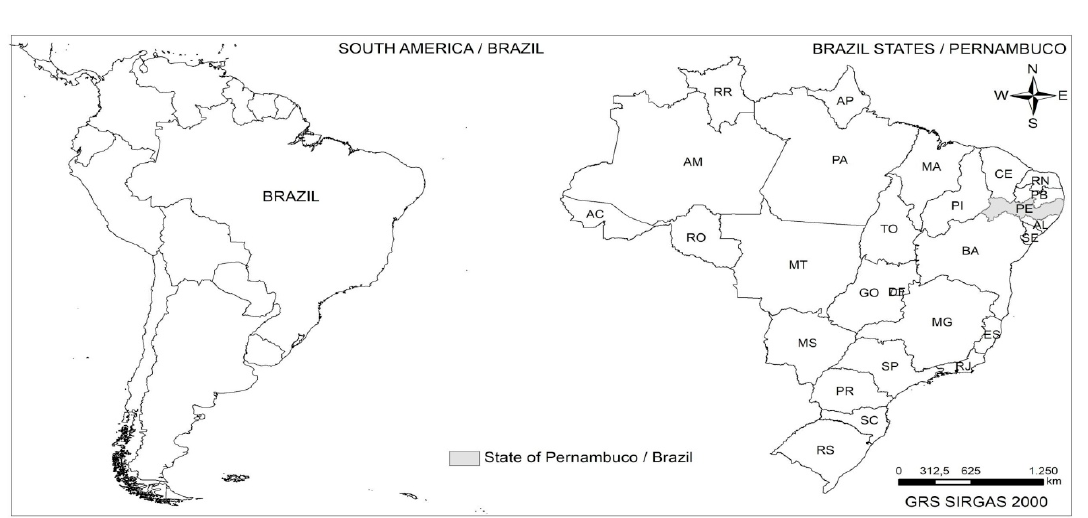
Figure 1. Location of the state of Pernambuco.